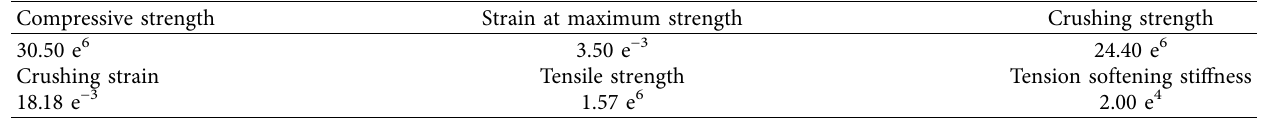
Table 5: Parameter values of confined concrete used in FE